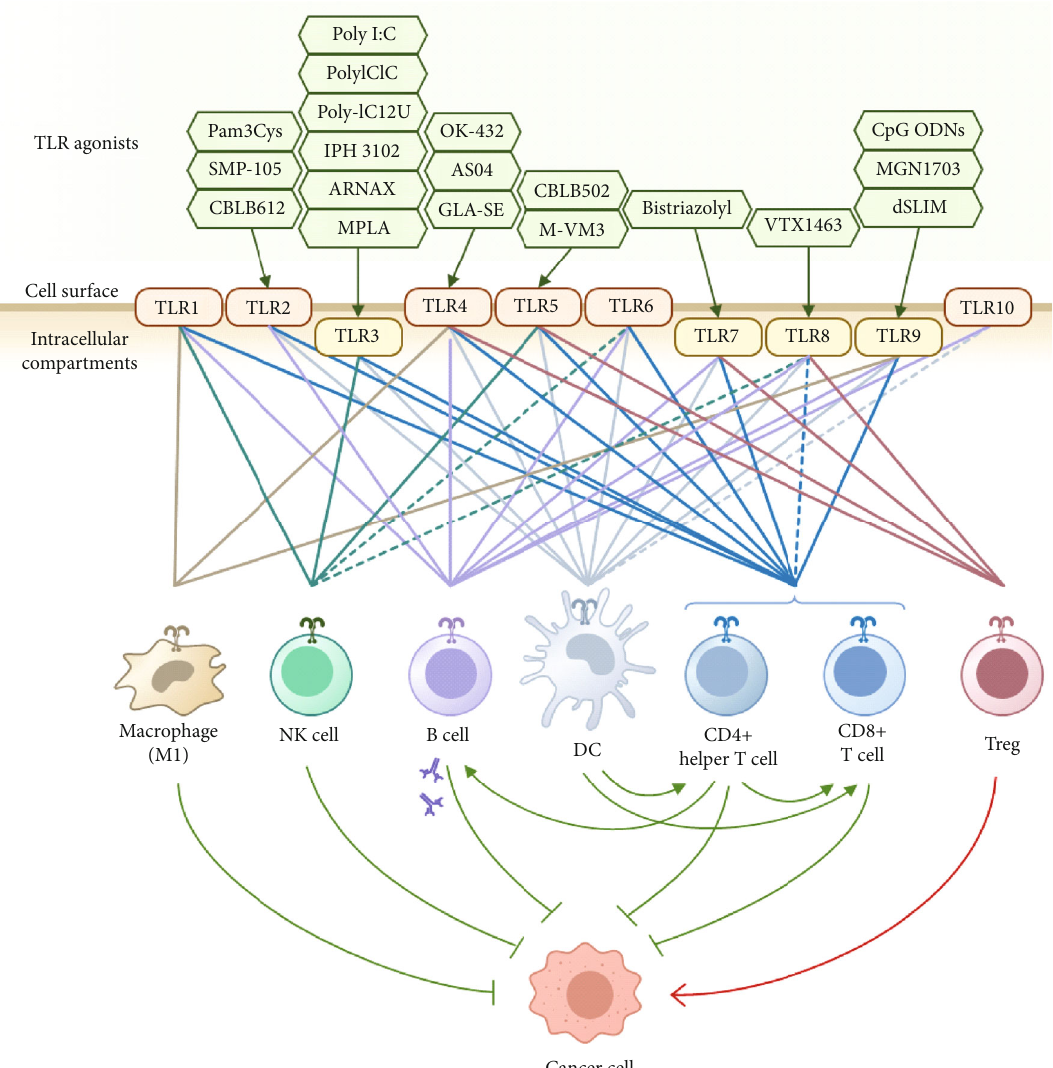
Figure 1: Targeting TLRs expressed on the immune cells in the tumor microenvironment with TLR agonists. Examples of TLR agonists are shown at the top. TLRs which are expressed in human cell surface or intracellular compartments are shown in the middle. The expression of each TLR on di ff erent immune cell types is indicated by color-coded lines. Some reported low-level expressions of TLRs with unknown functional status are ignored in this fi